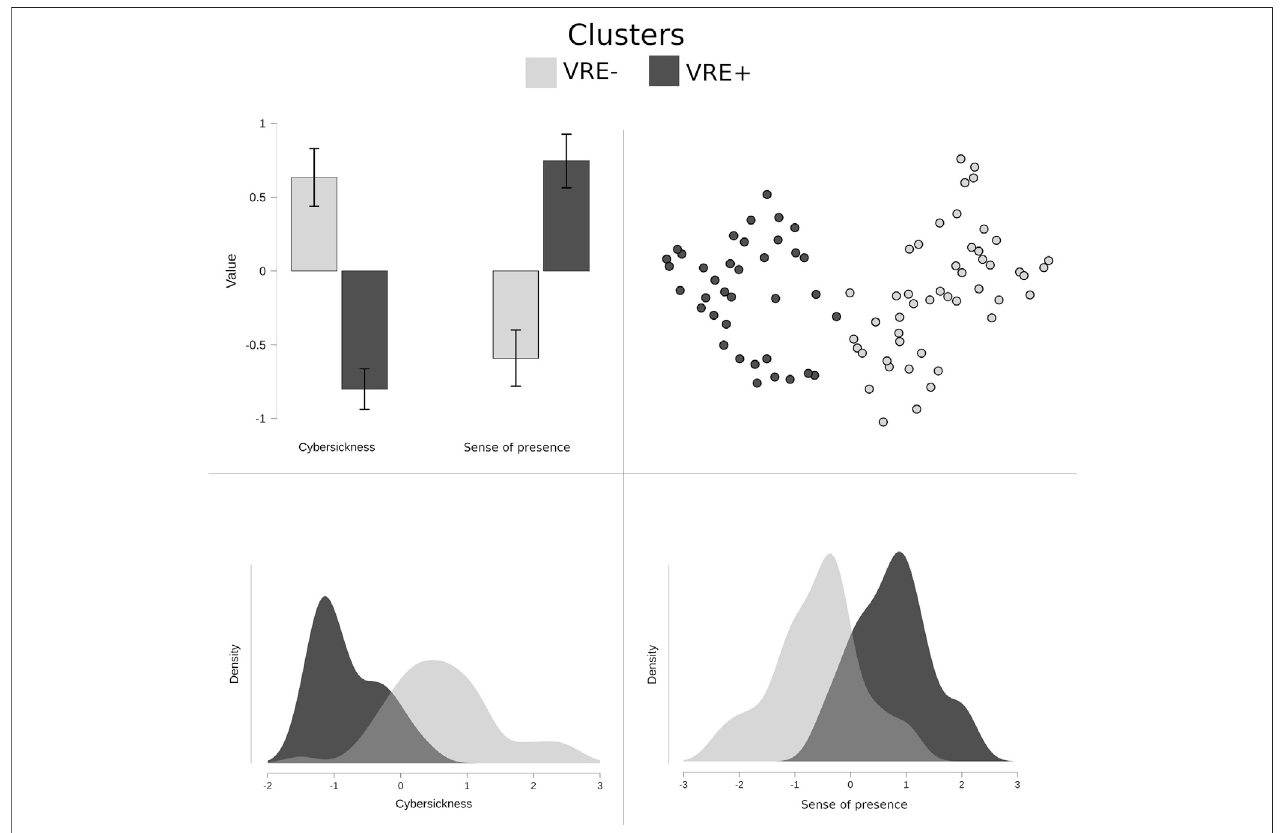
FIGURE 3 | Graphical representations of the K-means clustering analysis based on two dimensions (sense of presence, cybersickness), revealing two clusters (VRE for “ virtual reality experience - ” “ in light gray and VRE + for virtual reality experience + ” in dark gray). (A) Cluster mean plots, (B) t-distributed stochastic neighbor embedding (t-SNE) cluster plot. (C) Cluster density plot on cybersickness. (D) Cluster density plot on sense of presence.